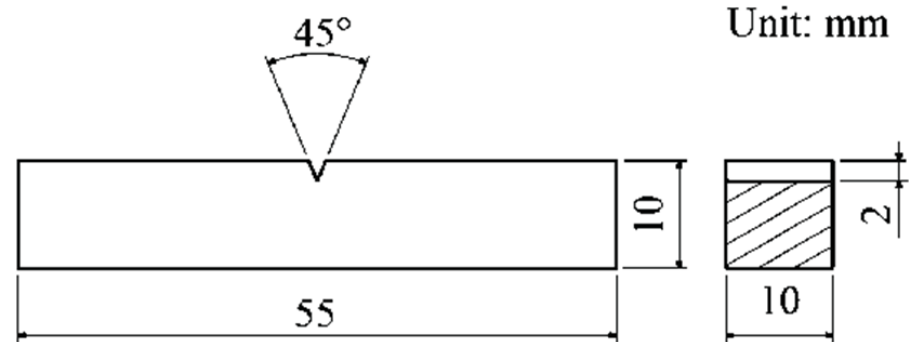
Figure 1. Dimensions of Charpy impact samples.